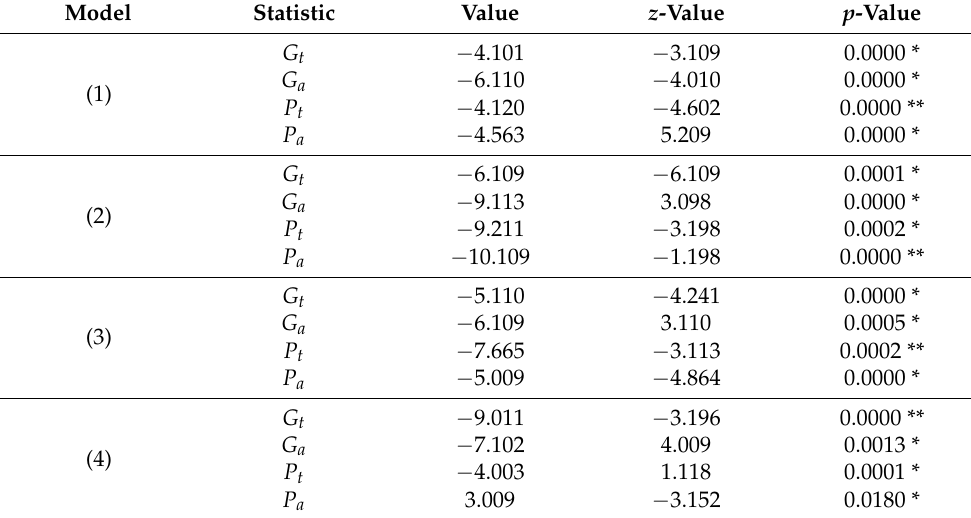
Table 5. Westerlund Cointegration